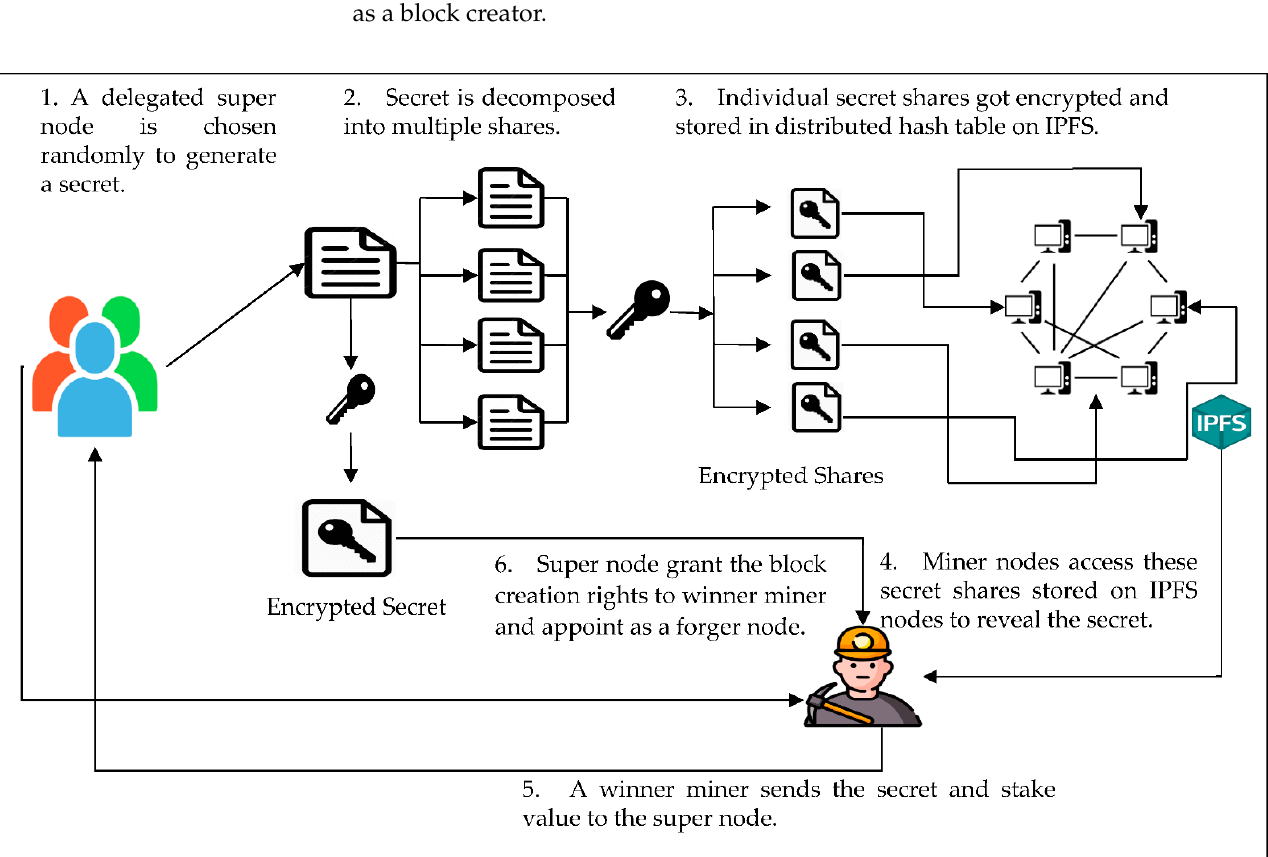
Figure 3. Proposed system design.